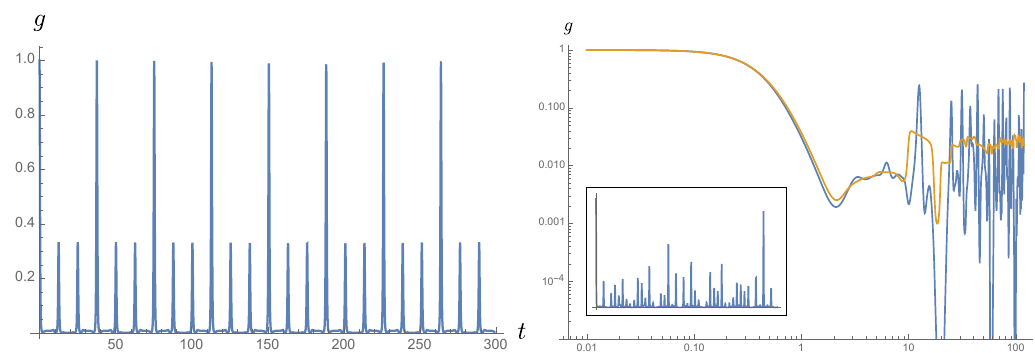
Figure 11 . Spectral form factor (blue) and its progressive time-averaged version (yellow) for (left) rational ( (cid:17) = 3) and (right) irrational ( (cid:17) = (cid:25) ) compacti(cid:12)ed boson theories. For progressive time averaging, we use (cid:11) = 0 : 9. Clearly, the spectral form factor has (cid:12)nite recurrence for the rational radius. It has in(cid:12)nite recurrence time for irrational radius. The inset shows linear axes scaling for the irrational